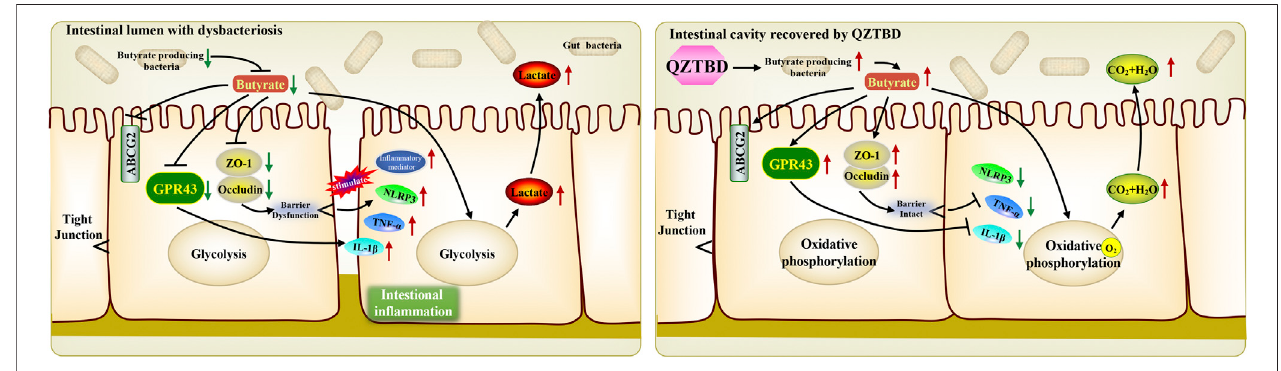
FIGURE 8 | Proposed mechanism of QZTBD in the treatment of gouty arthritis. In gout mice, the de fi ciency of gut butyrate-producing bacteria resulted in the decrease of intestinal butyrate content. Dropped butyrate inhibited the expression of GPR43 and intestinal tight junction related proteins, and further shifted the metabolism of colonocytes toward glycolysis and activated downstream in fl ammatory pathways. QZTBD increased the level of microbiota-derived butyrate by promoting the proliferation of butyrate-producing fl ora, thereby further activating the expression of SCFAs receptor GPR43, increasing the expression of intestinal tightjunctionrelated proteins, facilitatingthemetabolism ofcolonocytestowardoxidativephosphorylation,inhibitingdownstreamin fl ammatorypathwaysandeventually ameliorating gout. Red arrow indicates upregulation, green arrow indicates downregulation.